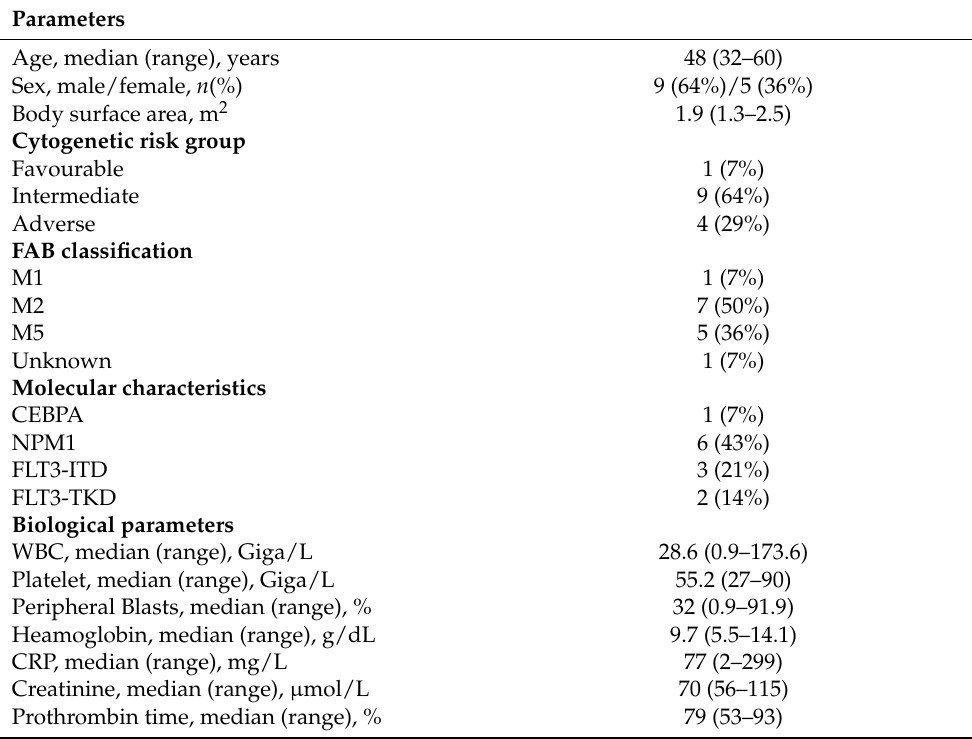
Table 1. Clinical and biological characteristics of the 14 included patients.